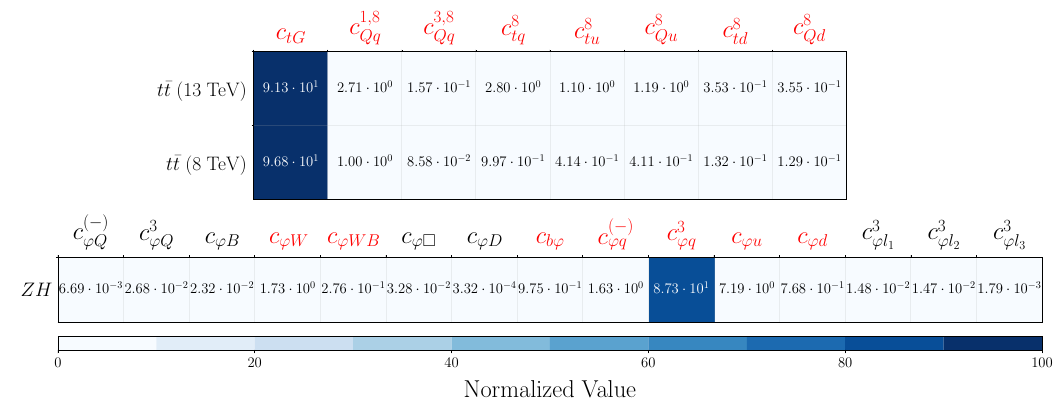
Figure 5. The diagonal entries of the Fisher matrix corresponding to the operators that enter the calculation of the LHC t ¯ t production at 8 TeV and 13 TeV (top) and of the hZ production at 13 TeV (bottom) [15], where each row is normalized to 100. The dark blue entry indicates the operator that dominates the Fisher information, and those marked in red are selected to construct the unbinned